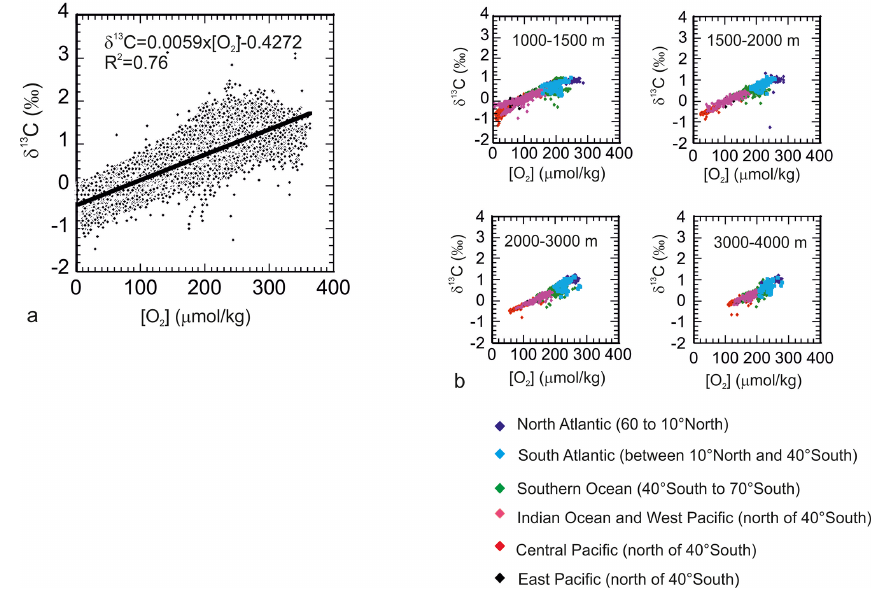
Figure 3. (a) Global relationship between seawater [O 2 ] and δ 13 C of DIC. (b) Cross-plots of seawater [O 2 ] and δ 13 C for intermediate (1000– 1500 and 1500–2000m) and deep (2000–3000 and 3000–4000m) waters. The data used to create this figure can be found in the Supplement and were obtained from http://www.nodc.noaa.gov/OC5/SELECT/dbsearch/dbsearch.html. Only World Ocean Database quality-controlled data with accepted values (e.g. flag 0) are